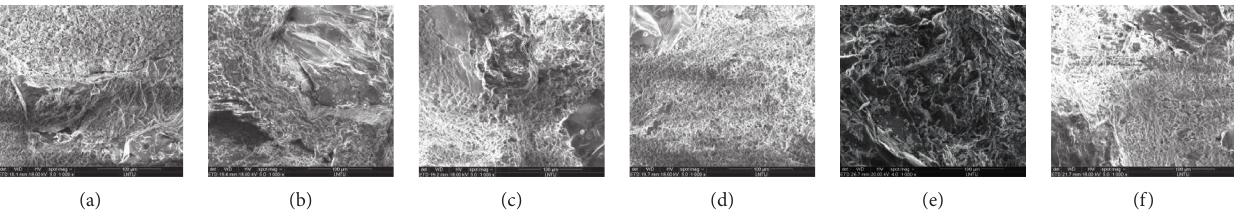
Figure 12: Microstructure of the feldspar sandstones (Group A) after the dry-wet cycles. (a) 0 T. (b) 5T. (c) 10T. (d) 15T. (e) 20T. (f) 25T.